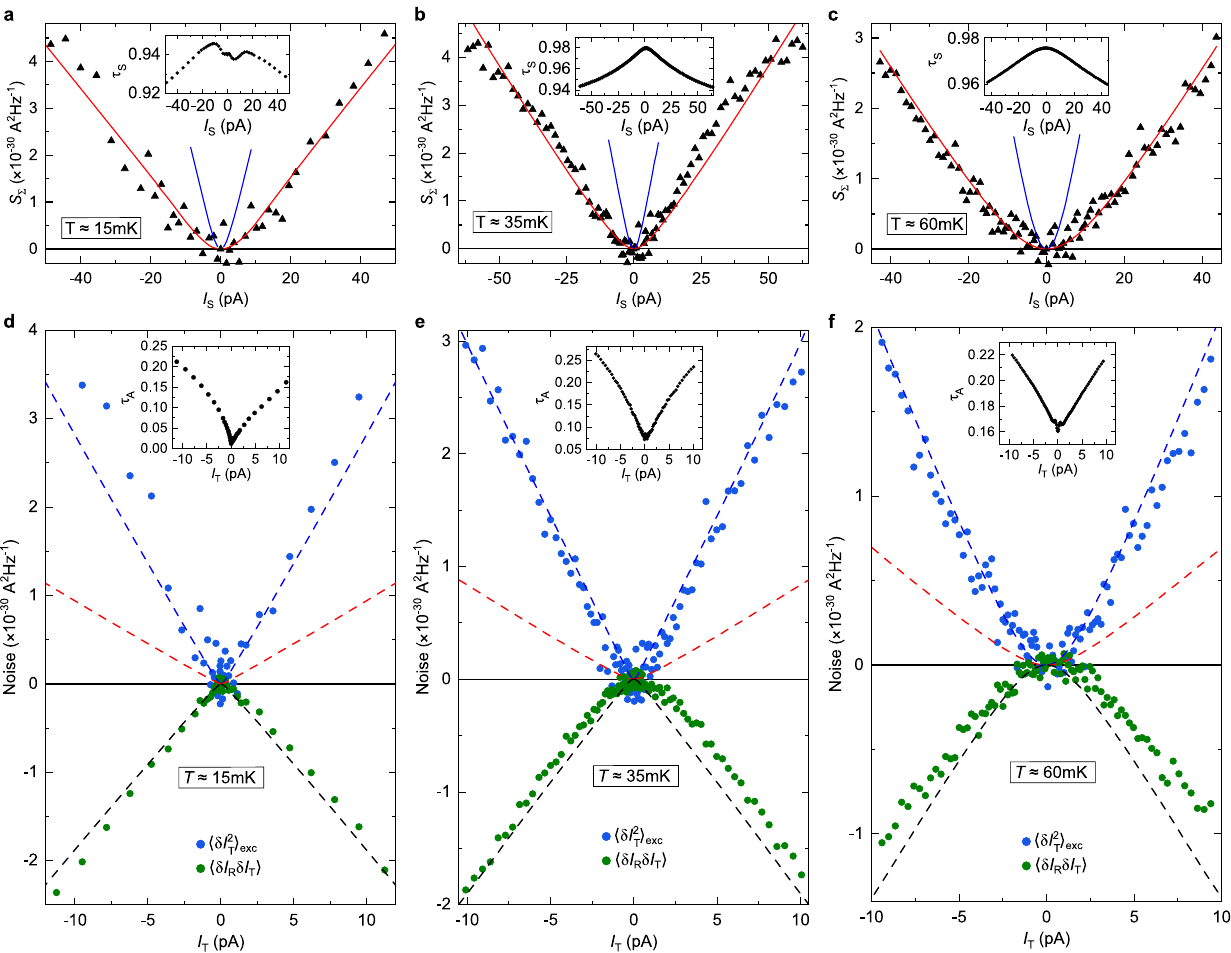
Fig.9|SupplementaryAndreevobservations,inthesourceWBS-analyzerSBS regime. The source QPC is here located on the opposite side of the analyzer than